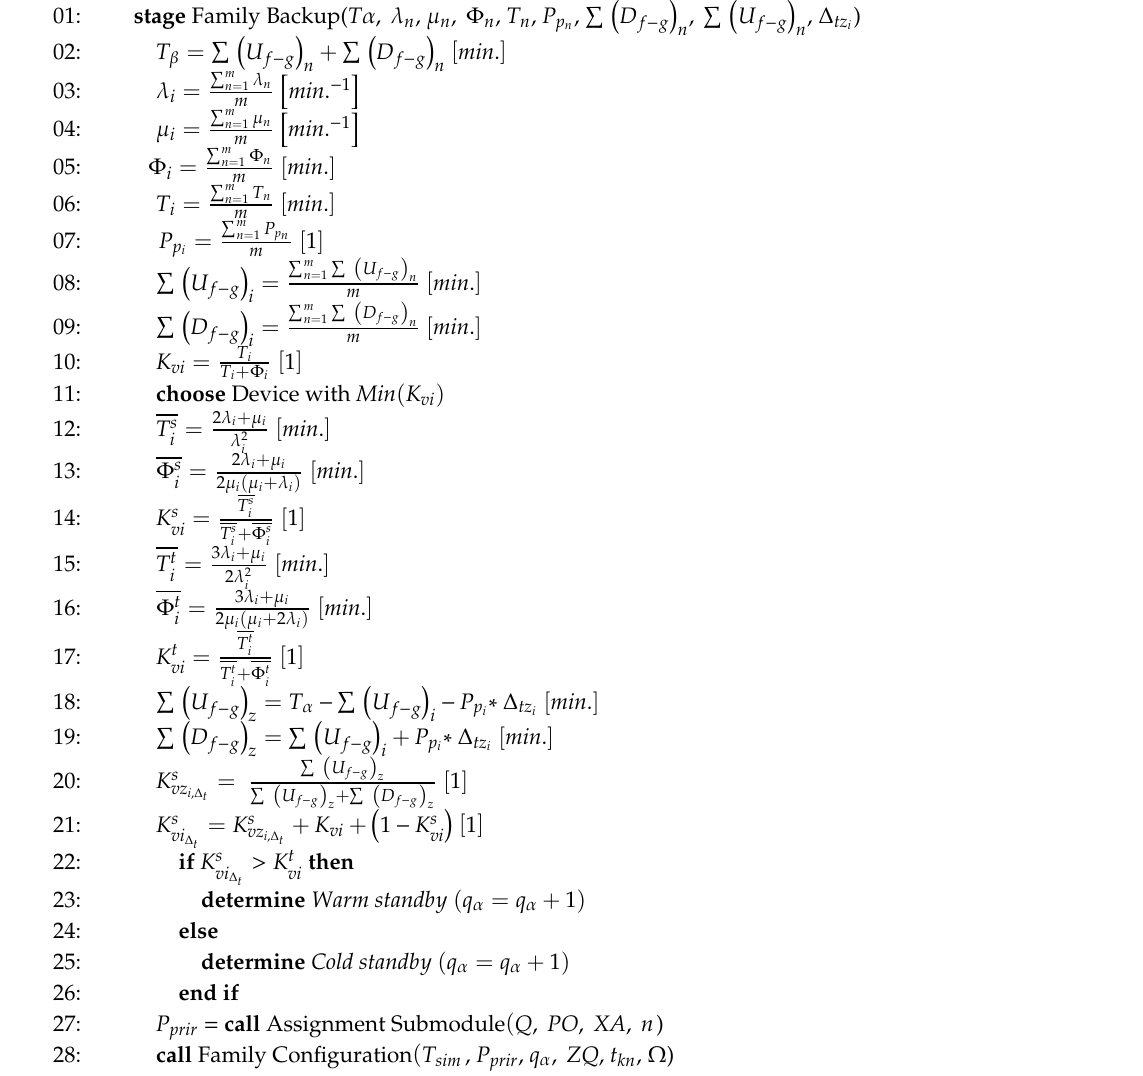
(cid:17) (cid:17) (cid:80) (cid:16) (cid:80) (cid:16) D f − g U f − g , , , ∆ tz n i n n